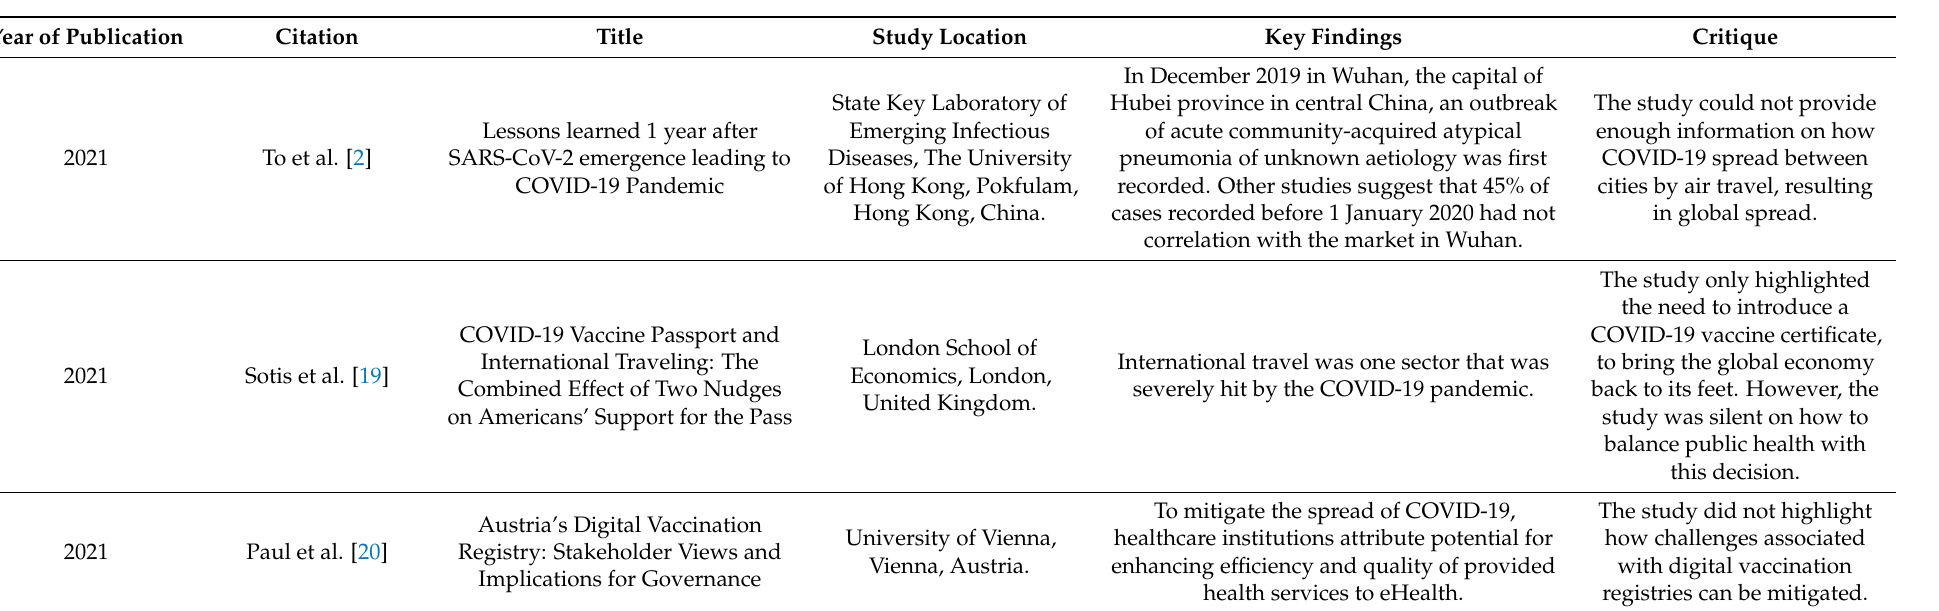
Table 5. Background of